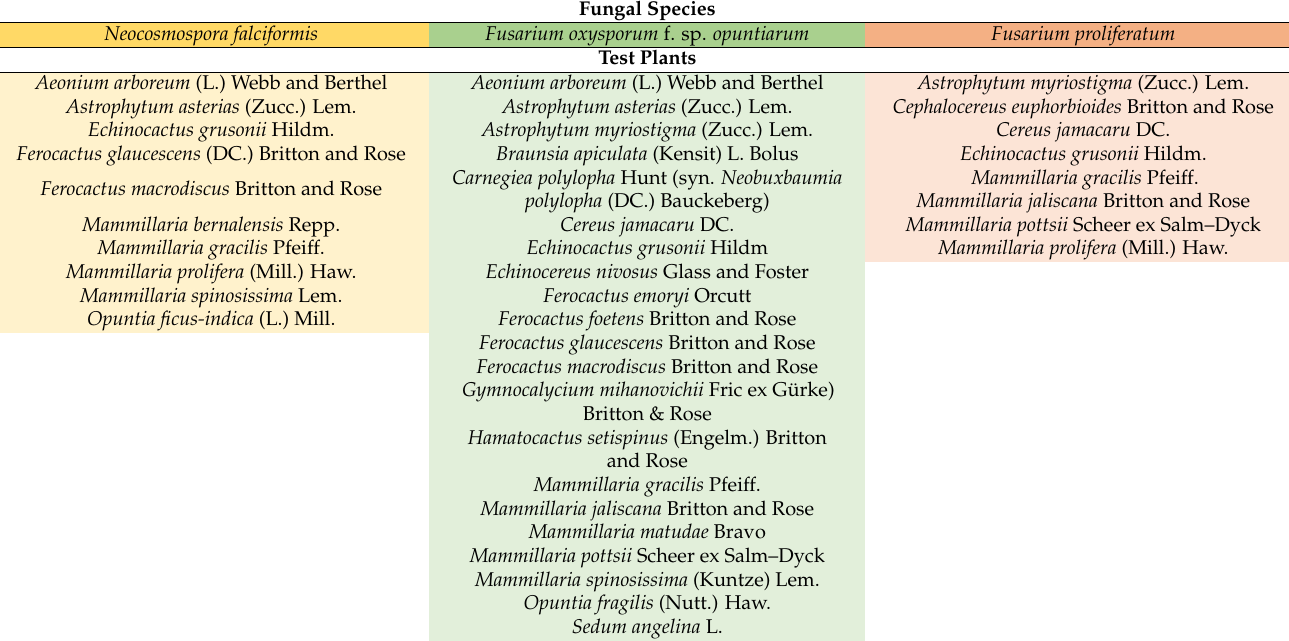
Table 2. Species of succulent plants that proved to be susceptible to three fusarioid fungal species in pathogenicity tests. Two diverse artificial inoculation methods were used: wound inoculation with a conidial suspension (10 6 conidia mL − 1 ) and inoculation through the soil with infested wheat grains as